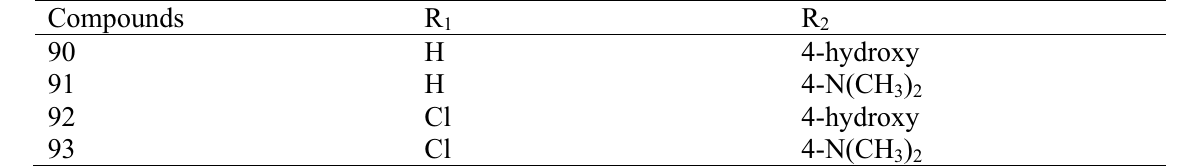
Table 29 Antioxidant activities of the synthesized deriva- tives